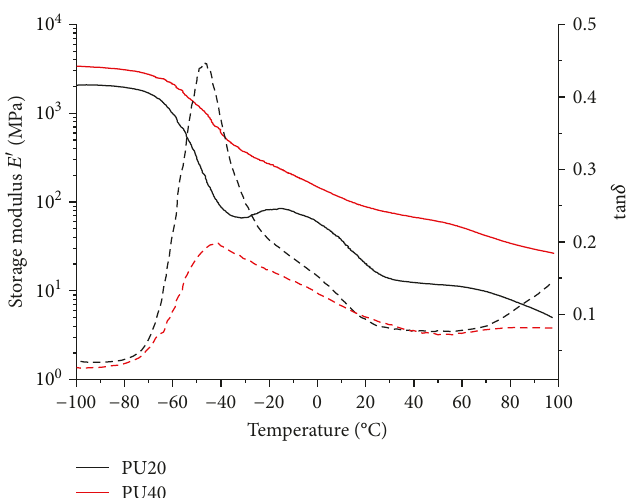
Figure 6: Storage modulus ( E ′ /MPa — black line) and loss tangent (black dot line) versus temperature/ ° C for nonmodi fi ed PU matrices with di ff erent hard segment contents.